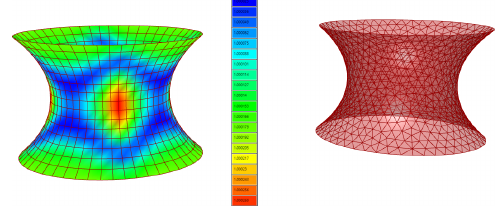
Figure 16: Catenoid solution for h = 1.30 r . BATS on the left, Kanga- roo on the right